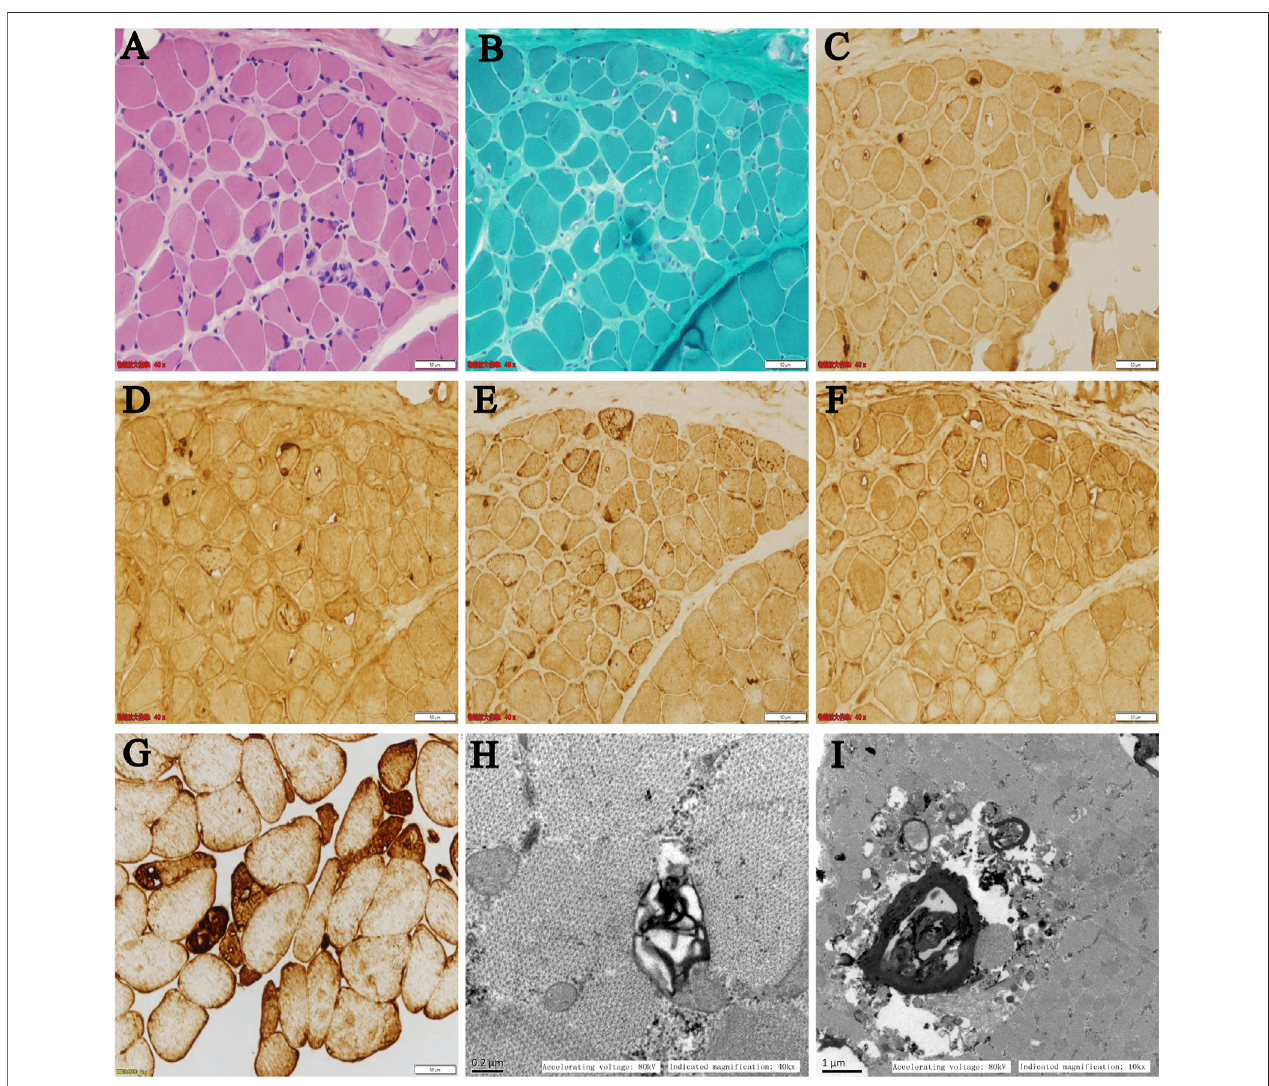
FIGURE 2 | (A – F) Serial sections from the patient ’ s left biceps brachii muscle on light microscopy: (A) HE and (B) MGT staining revealed mildly proliferated connectivetissueand fi bersizevariationwithatrophic fi bers.Rimmedvacuoleswerefoundinaportionofthe fi bers.Immunohistochemistryshowedpositivereactivityfor (C) TDP-43, (D) p62, and (E) LAMP2 in the rimmed vacuoles. (F) LC3 reactivity was absent or less abundant in the rimmed vacuolar regions. (G) Desmin reactivity showed moderate or strong expression in rimmed vacuolated fi bers. (H,I) Ultrastructural changes on electron microscopy: (H) myelin bodies and (I) destroyed myo fi brillar structure replaced by loop debris materials were found on transverse